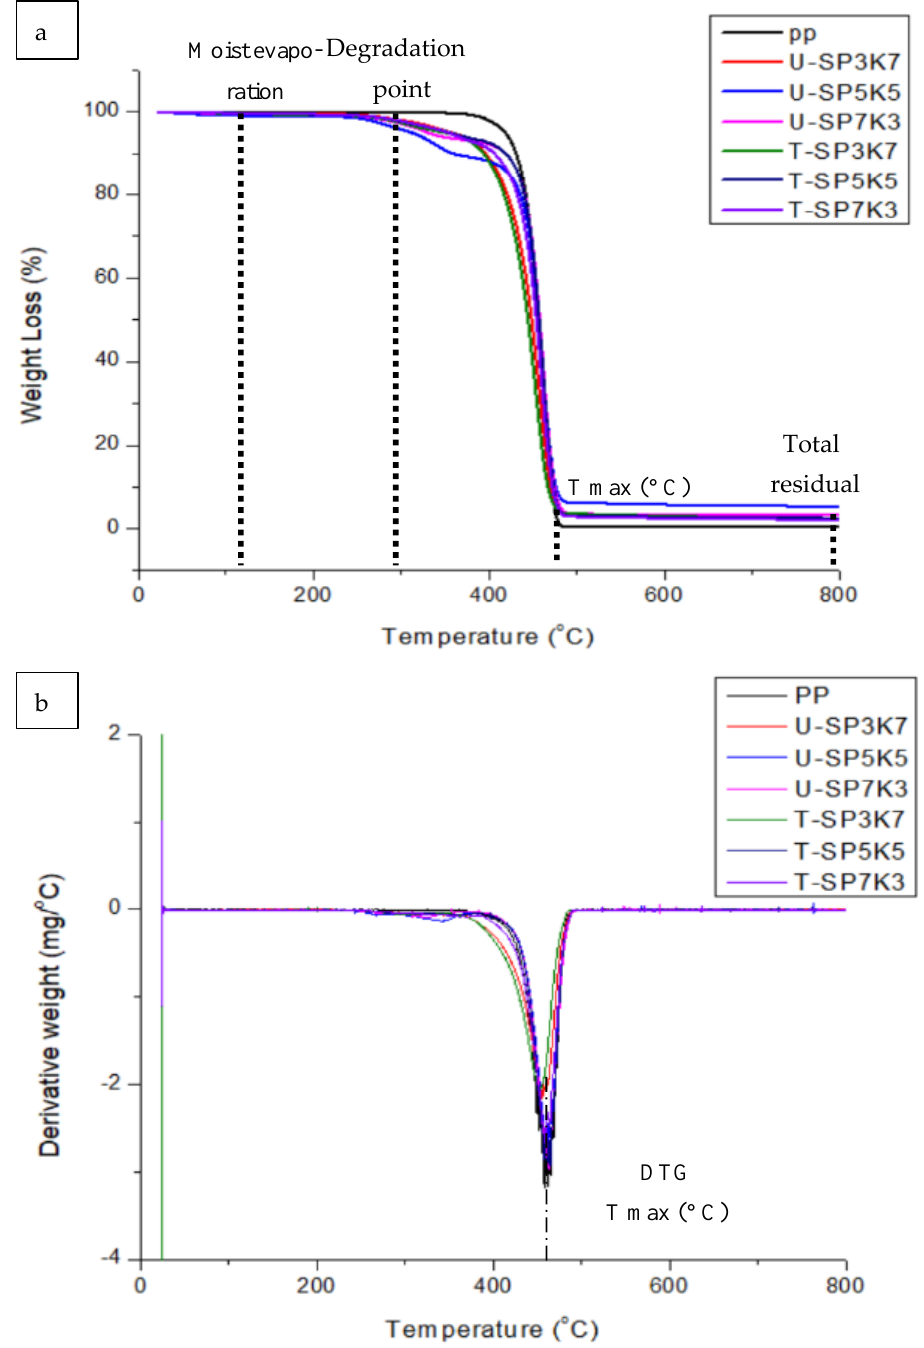
Figure 3. TGA composite hybrid SPF/KF/PP with varied composition: ( a ) Weight loss (%) analysis of SPF/KF/PP; ( b ) Derivative thermogravimetric (DTG) of SPF/KF/PP.